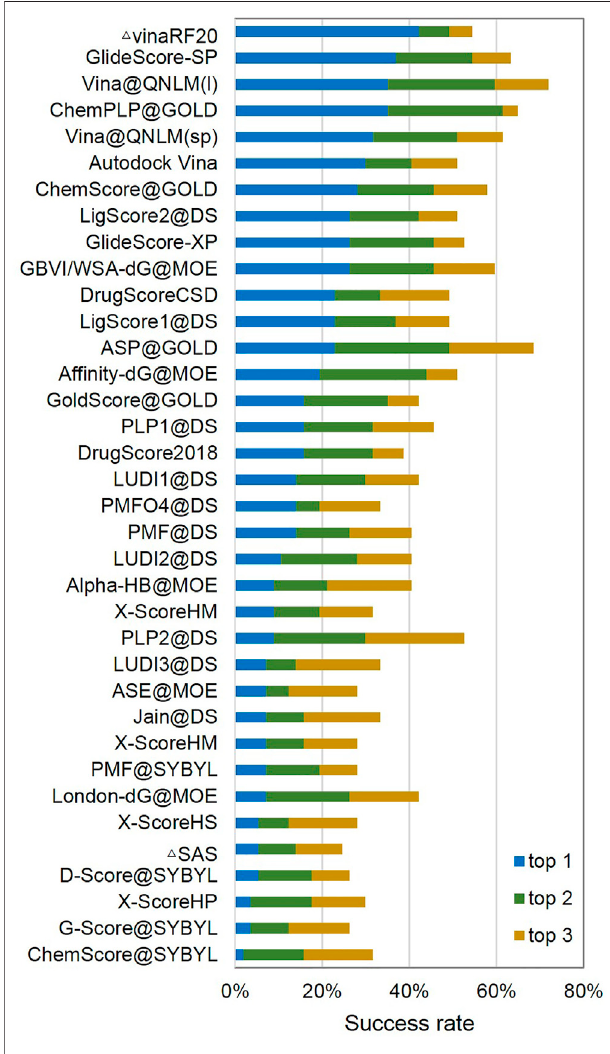
FIGURE10| Screeningpoweroftop1(1%),top2(5%),andtop3(10%) forward screening success rates of Vina@QNLM in single-point and local modes (blue, green, and orange bars), compared tothe methods evaluated in CASF-2016 and